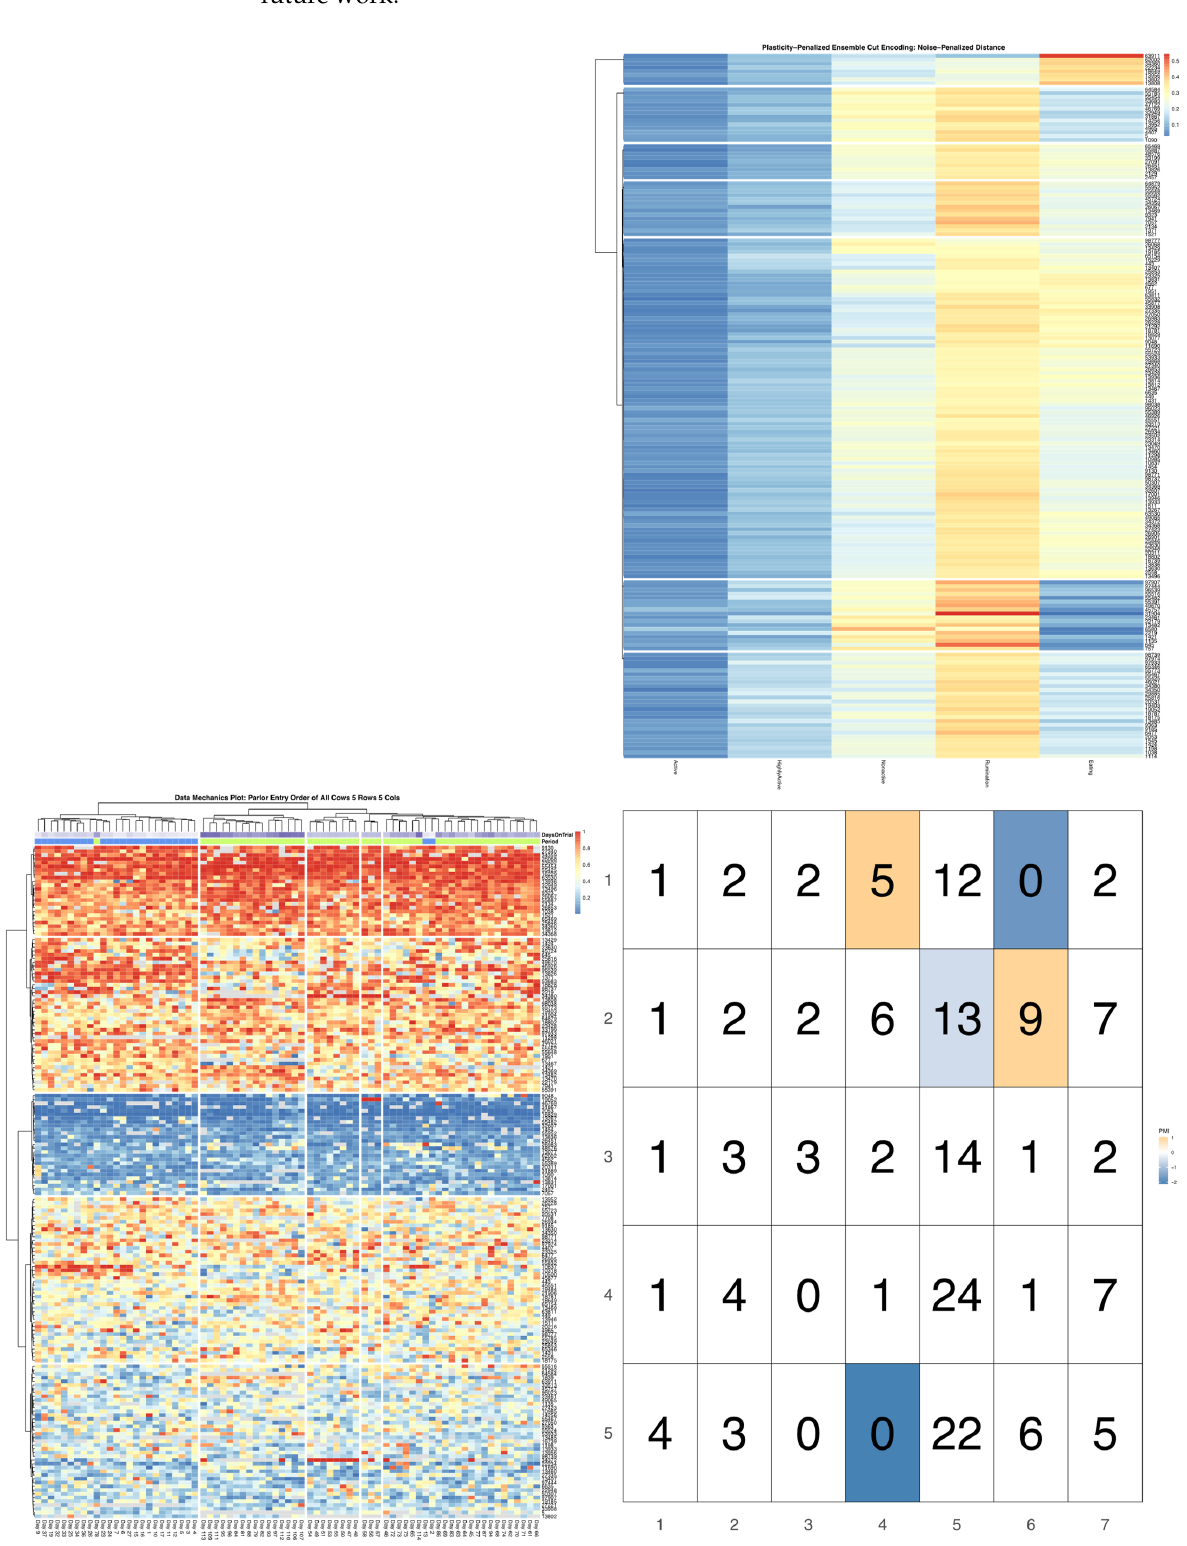
Figure 5. Visualization produced using the compareEncoding utility with cells colored by pointwise mutual information estimates significant at the alpha = 0.05 significance level after simulations using